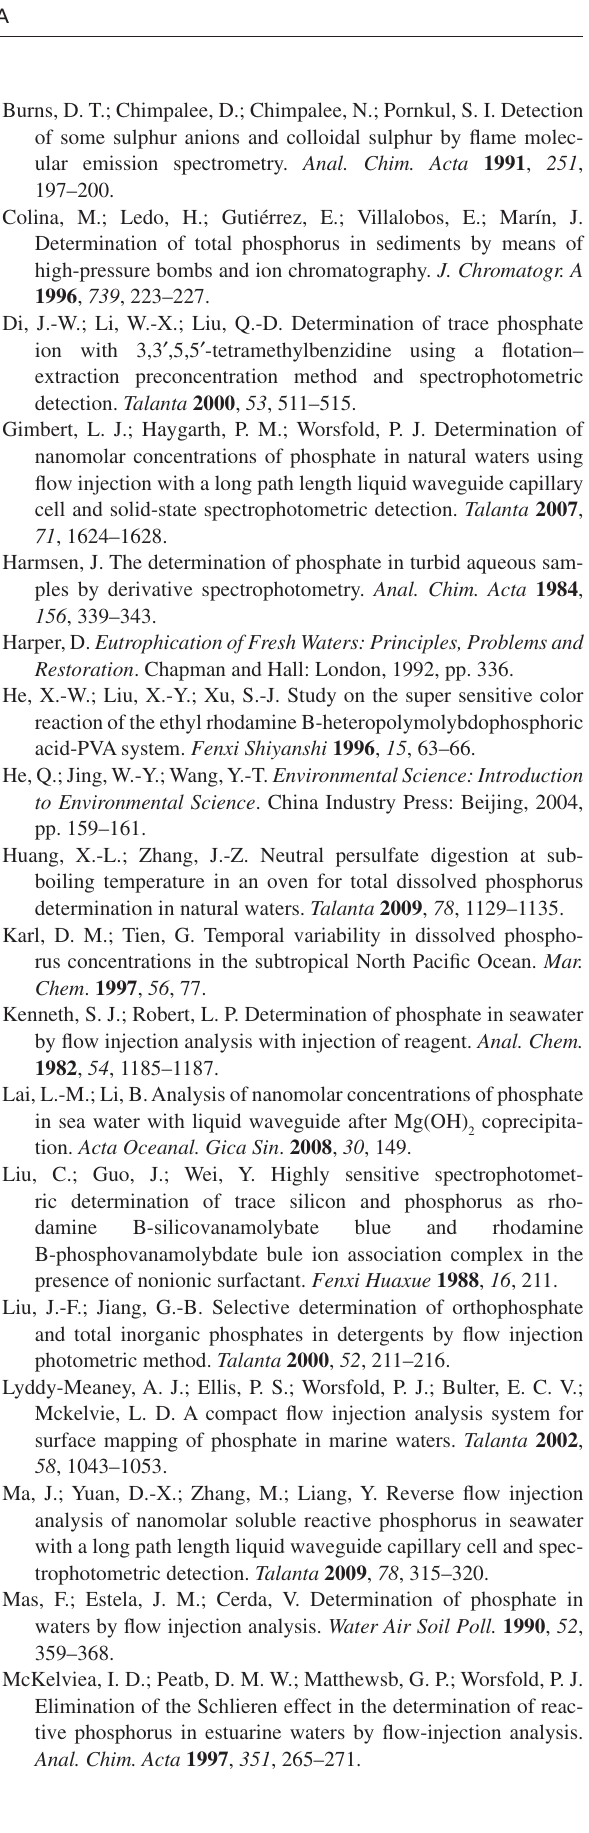
Table 4 Determination of PO 3-